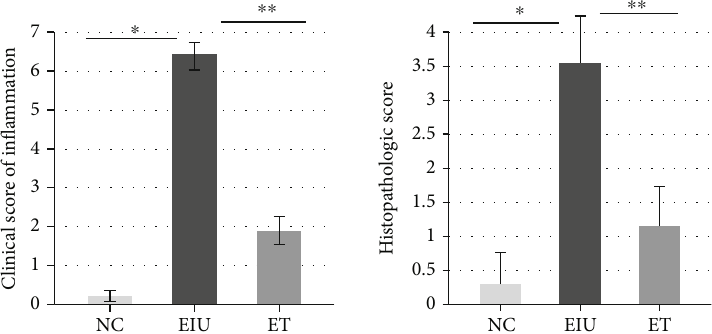
Figure 2: Clinical score results. All data shown as mean ± standard deviation ( n = 20 , eye). ∗∗ P < 0 : 05 , signi fi cantly di ff erent from EIU